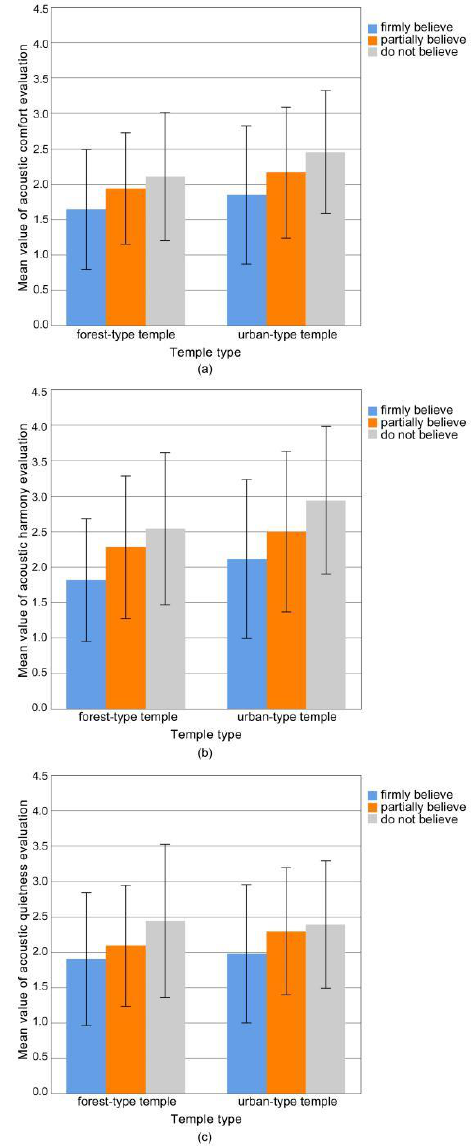
Figure 4. The evaluation value and standard deviation of acoustic environment by different re- spondents’ attitude towards Buddhist thought: ( a ) comfort; ( b ) harmony; ( c ) quietness. dents’ attitude towards Buddhist thought: ( a ) comfort; ( b ) harmony; ( c )